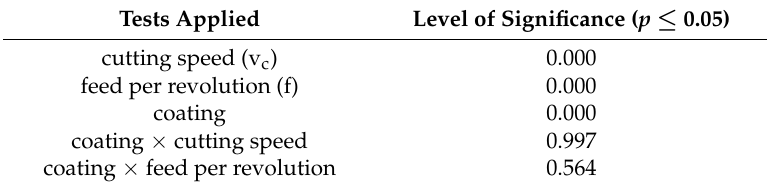
Table 4. Significance level of the effect of cutting parameters on the average thrust force (F t